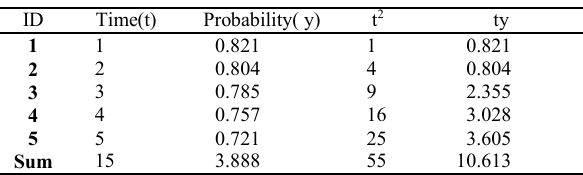
Table 5. Data of linear